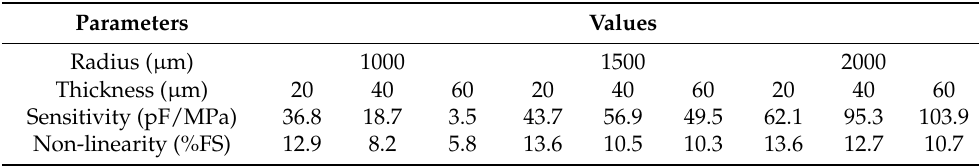
Table 1. Performance of CPSs with different sizes of diaphragms.